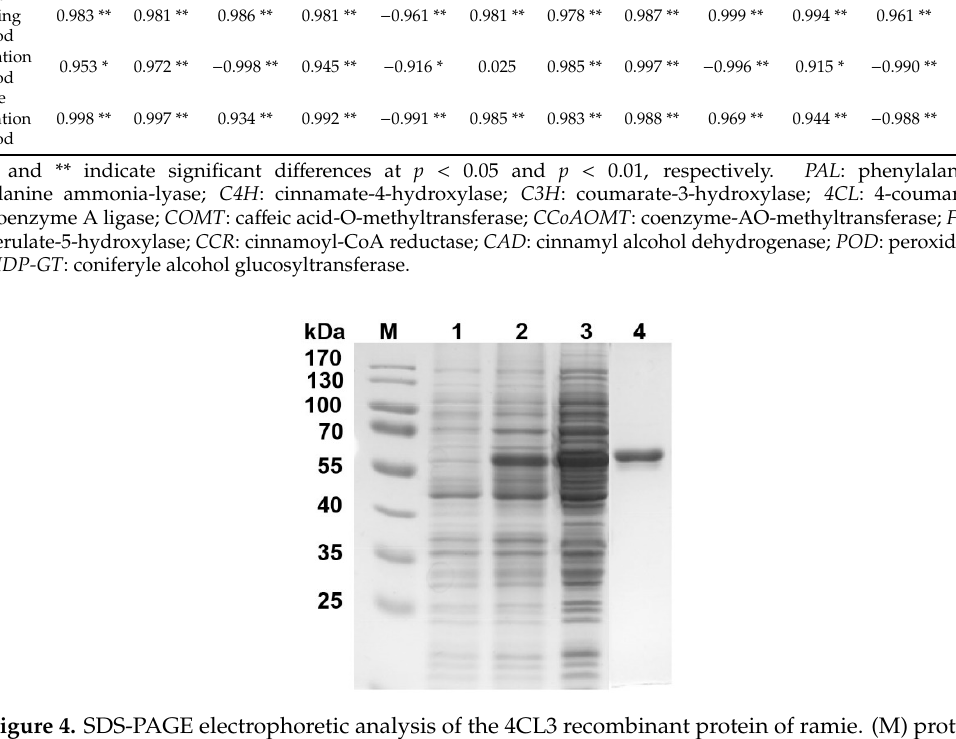
Table 4. Correlation coe ffi cients of lignin content and its related key genes expression.